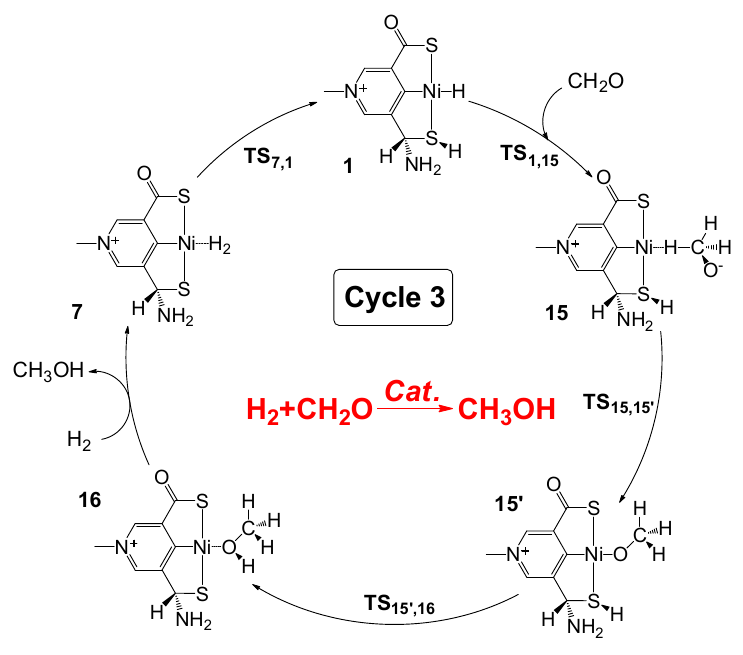
Scheme 3. Predicted mechanism for hydrogenation of formaldehyde.